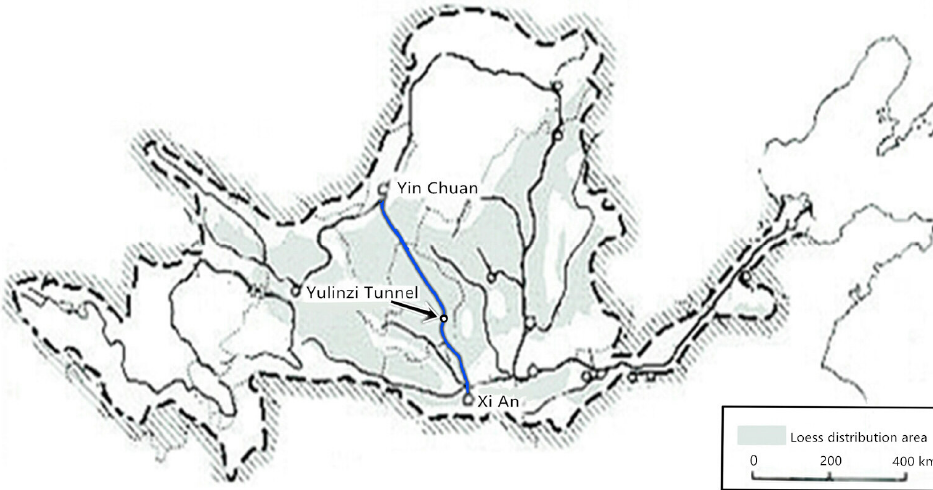
Figure 1. The location of the Yulinzi Tunnel in the loess distribution area.